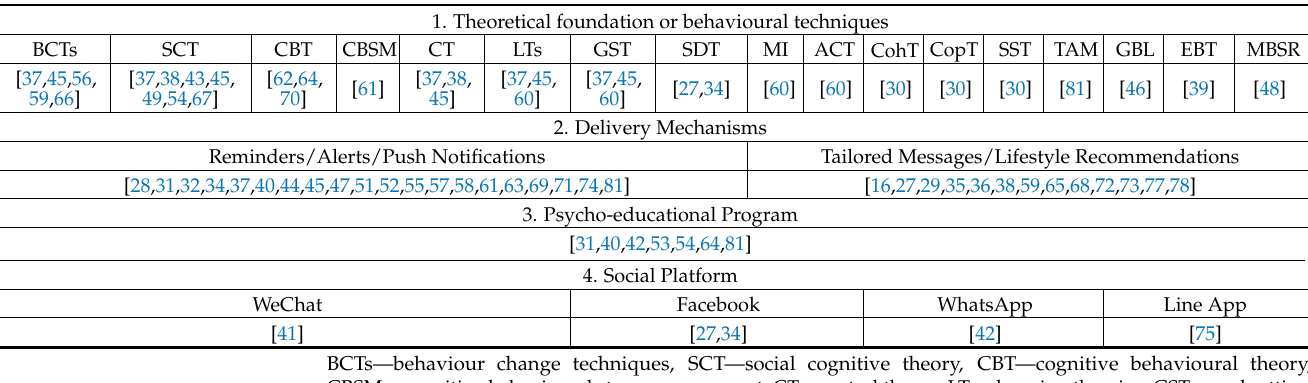
Table 4. Taxonomy of the included studies based on four